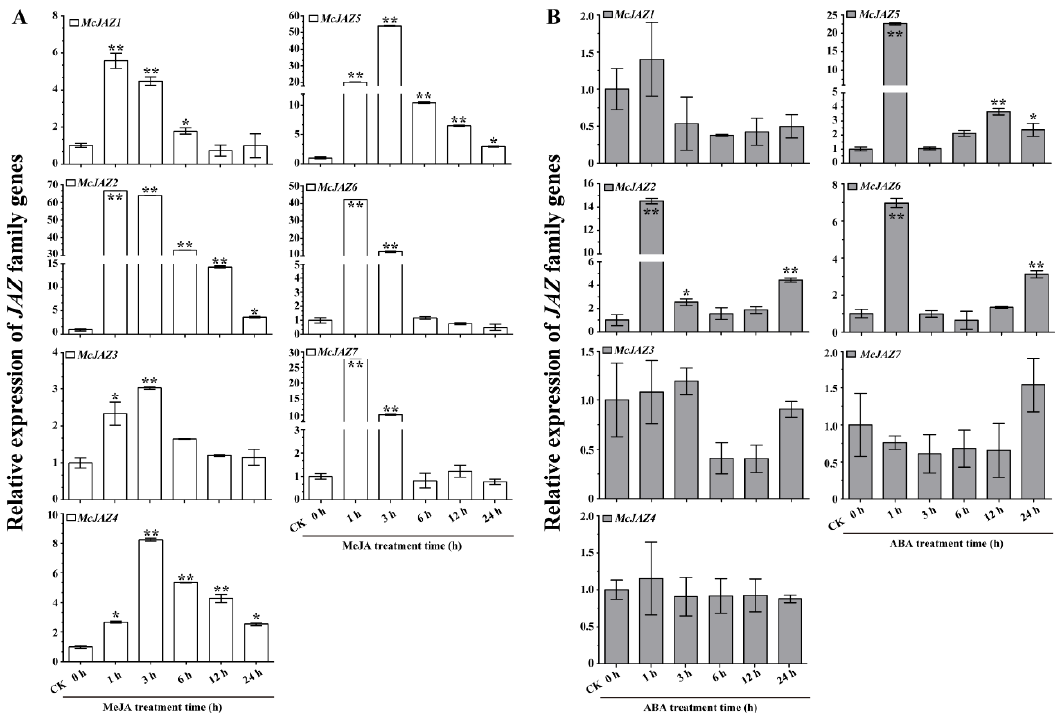
Figure 5. Expression profiles of McJAZ genes under phytohormone MeJA and ABA treatments . Quantitative real-time (qRT)-PCR analysis of the expression levels of McJAZ1 , McJAZ2 , McJAZ3 , McJAZ4 , McJAZ5 , McJAZ6 , and McJAZ7 in the two-week-old M. canadensis seedlings under 100 μ M Methyl Jasmonate (MeJA) ( A ) or 20 μ M Abscisic Acid (ABA) ( B ) treatments for 0, 1, 3, 6, 12, and 24 h, respectively. The relative expression level of each McJAZ gene was normalized to β -actin gene and compared with CK (0 h) as reference using the 2 − ∆∆ Ct method. Data are presented as means ± SE of three independent replicates from three propagated cuttings. Asterisks indicate significant differences between the expression level of each McJAZ gene in CK (0 h) versus other time points were analyzed by Student’s t -test (* p < 0.05 or ** p < 0.01). CK (0 h) represents an independent control under identical conditions.